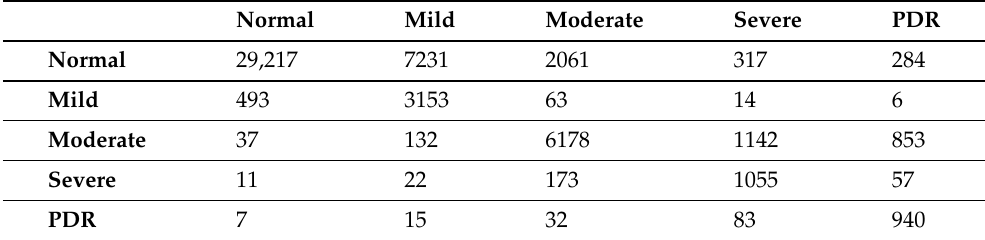
Table 8. Confusion matrix for CNN 3 (HSV Images), Accuracy = 75.67%.